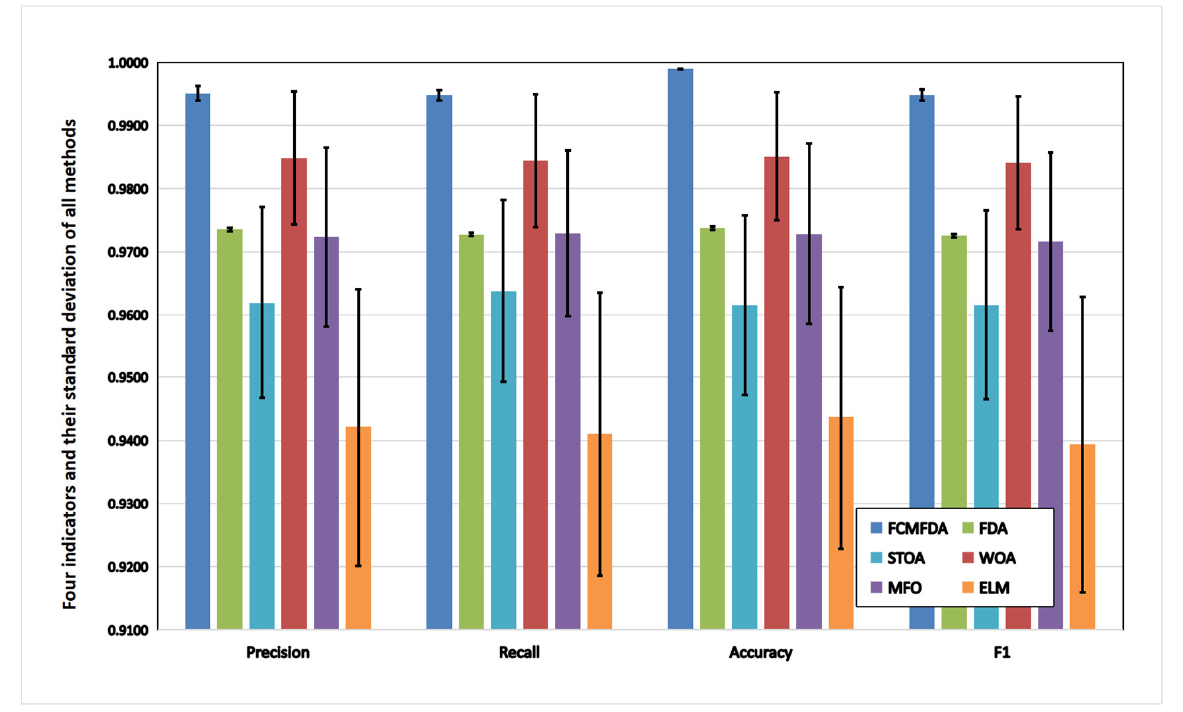
17 of 27 Table 8. indicators of each algorithm (Fish4Knowledge). Method